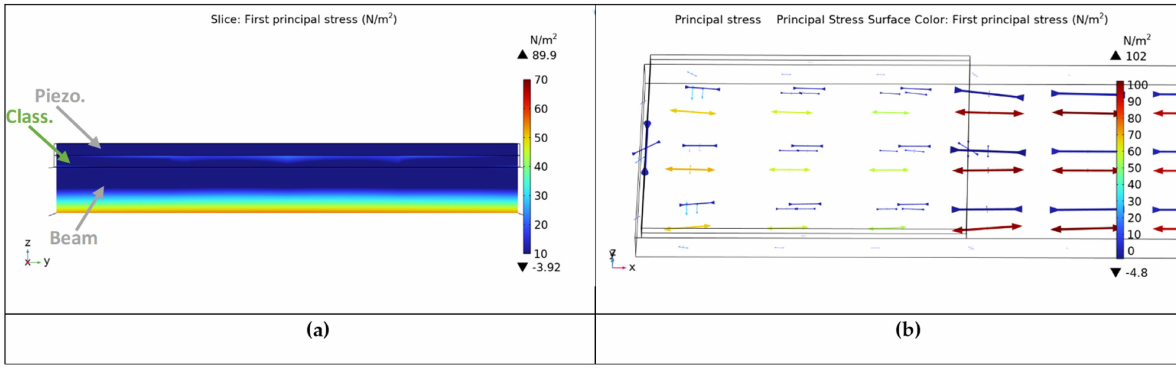
Figure 5. Stresses for the classical layer. ( a ) cross-section and ( b ) principal stresses.